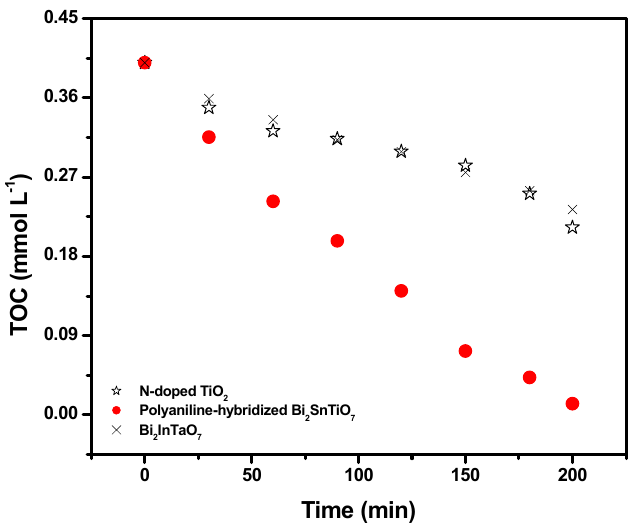
Figure 4. Disappearance of total organic carbon (TOC) during photocatalytic degradation of methylene blue with the polyaniline-hybridized Bi as catalyst under visible light